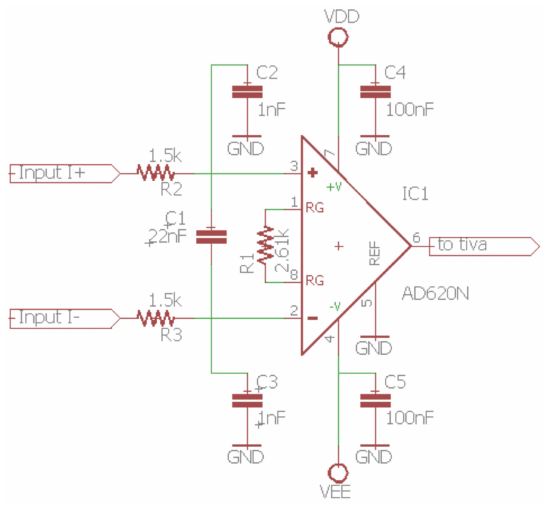
Figure 5. Amplification stage for the current